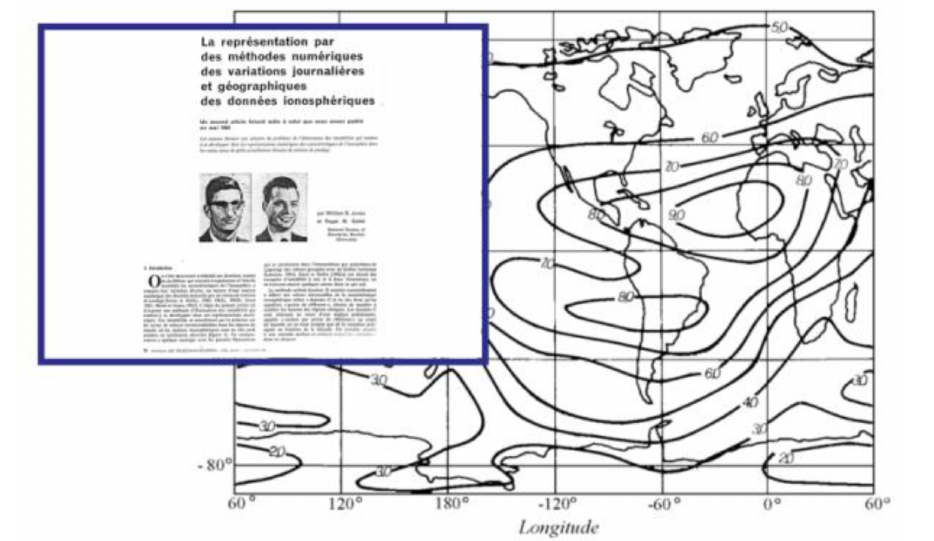
Figure 2. An example of a predicted median MUF(0)F2 map and the first page of the paper by W. B. Jones and R. M.